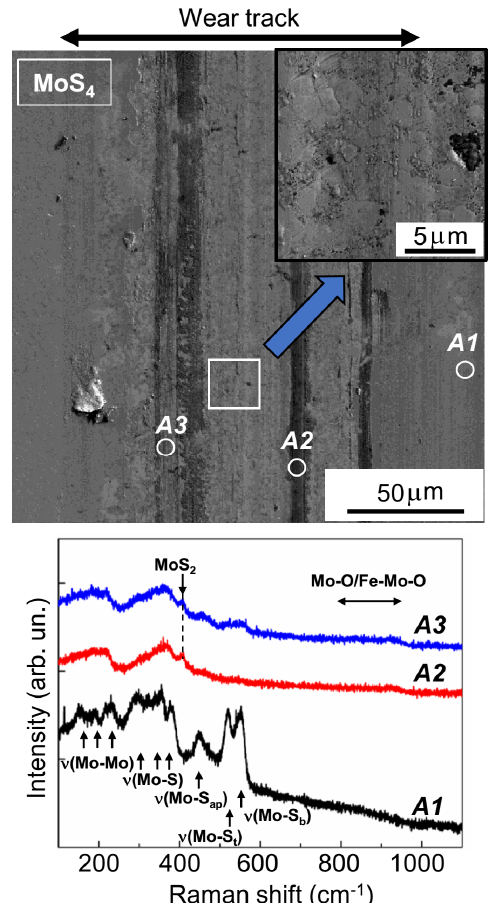
Figure 10. SEM image and Raman spectra of MoS 4 coatings subjected to tribo-testing at −100 °C in the argon–air mixture (RH ~ 9%). Raman spectra were measured on the unworn surface of the coating (area A1 ) and in two different local areas of the wear track (areas A2 and A3 ).